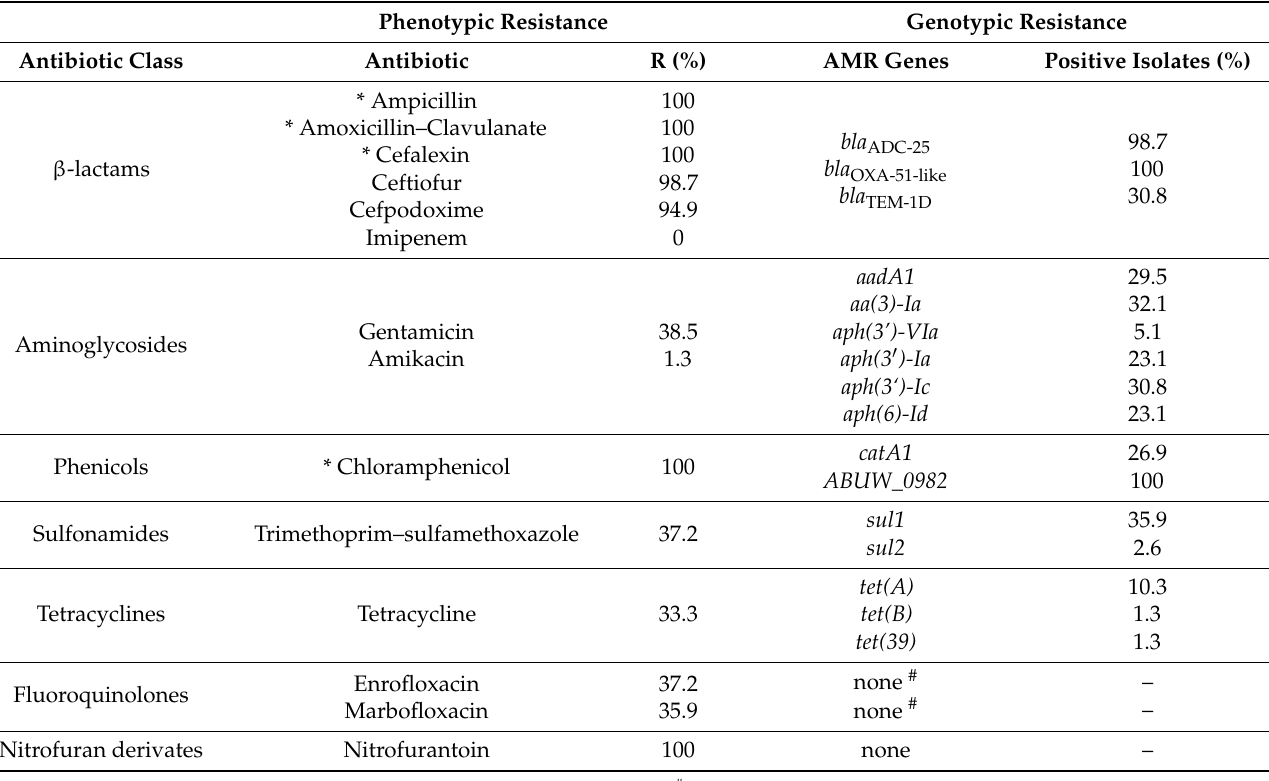
Table 2. Antimicrobial resistance phenotype and AMR genes of 78 equine A. baumannii isolates. Phenotypic